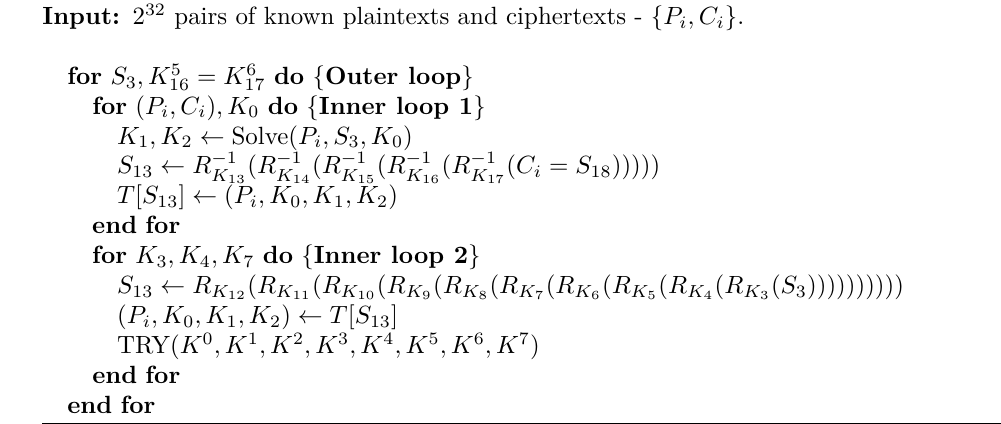
Algorithm 1 Pseudocode of the reflection attack against